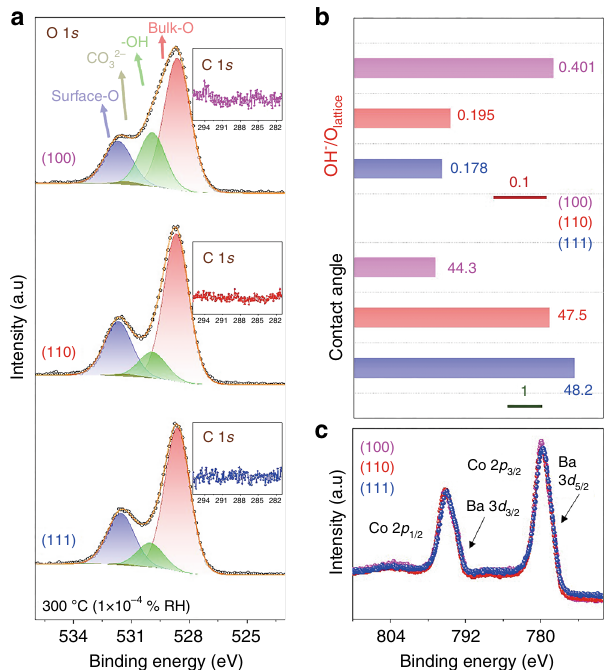
Fig. 6 Surface adsorbate coverage on different surface orientation. a O 1s, ( c ) Co 2p/Ba 3d spectra for (100), (110) and (111) thin fi lms in 1 mbar H 2 O at 300 °C (1 × 10 − 4 % RH). b Comparison of HO − /O lat ratio for (100), (110) and (111) thin fi lm in 1 mbar H 2 O at 300 °C (1 × 10 − 4 % RH), Contact angle for (100), (110), and (111) thin fi lms (the scales bar was marked inside the fi